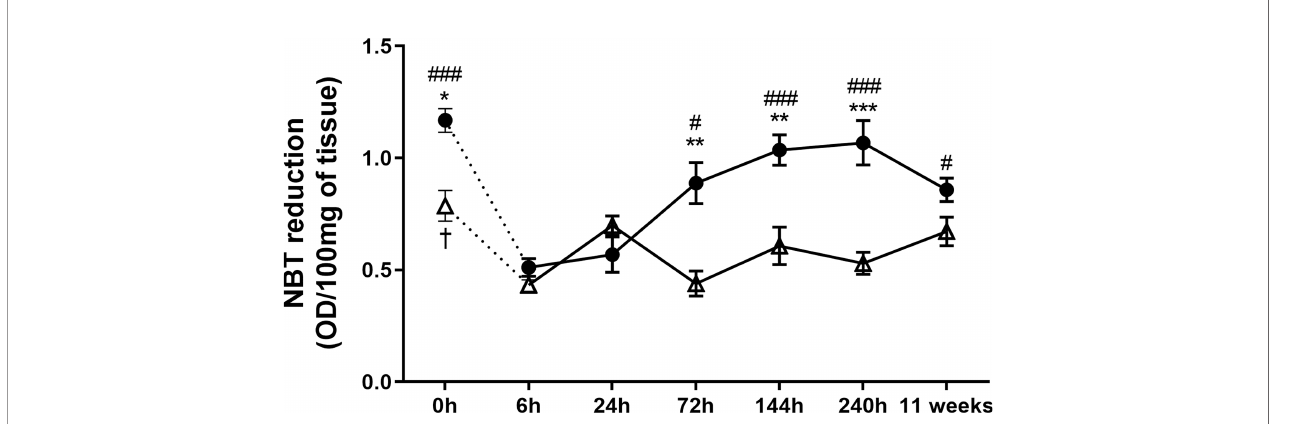
FIGURE 3 | Superoxide anion measured at the paws of BALB/c and C57BL/6 mice infected with L. amazonensis . Homogenates of BALB/c and C57BL/6 paws infected with L. amazonensis from 6 h to 11 weeks submitted to the NBT assay. Uninfected mice were used as controls (0 h). * Signi fi cant difference between mice strains infected by L. amazonensis , p ≤ 0.05; **p ≤ 0.01, ***p ≤ 0.001. # Difference in the time points vs. 6 h within C57BL/6 mice, p ≤ 0.05, ## p ≤ 0.01, ### p ≤ 0.001. † Difference in the time points vs. 6 h within BALB/c mice, p = 0.016. Data represent the mean ± SEM of six mice